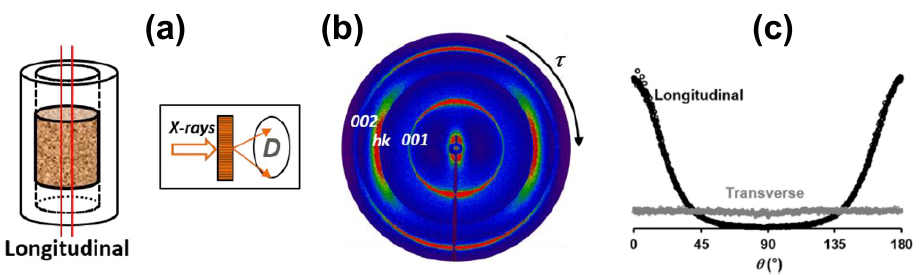
Figure 17. Determination of the orientation distribution functions of kaolinite particles within centrifuged clay samples by using 2D X-Ray Scattering patterns analysis. The longitudinal direction corresponds to the compression axis of the clay sample. ( a ) Schematic view of the experimental setup; ( b ) experimental 2D-XRS patterns and ( c ) orientation distribution functions (ODF) from the angular scan of the 001 reflection extracted from the 2D-XRS patterns. Reprinted from Ref. [52]. Copyright (2020), with permission from